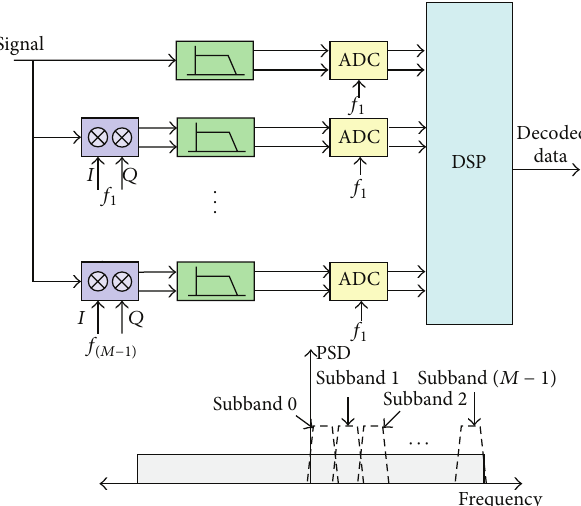
Figure 6: Low-pass filter bank approach for channelization.